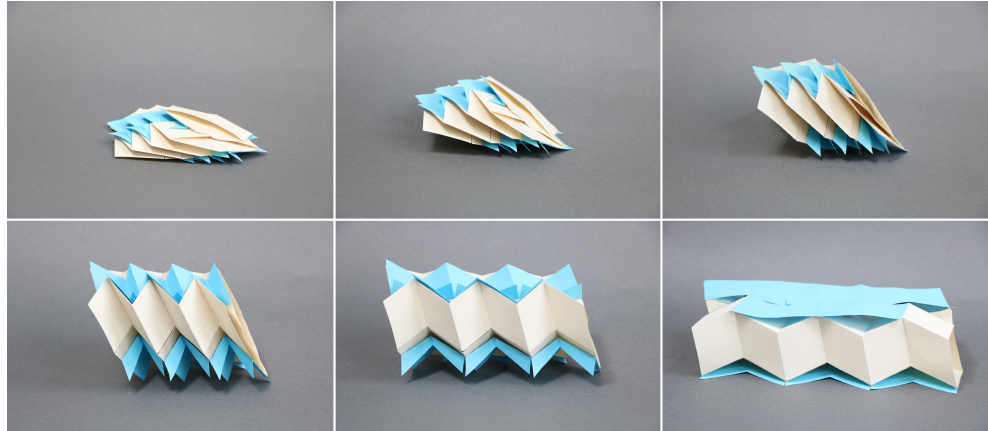
Figure 10. Model of asymmetric zipper-coupled tubes with a Miura-ori inspired smooth sheet attachment at different stages of unfolding; the nature of the deployment of the degree-four vertex cells is clearly observable on the bottom of the device. Parameters: α 1 = 1 Dimensions (inches): 4.9 by 3.3 when folded, 7.4 by 3.5 by 1.5 when